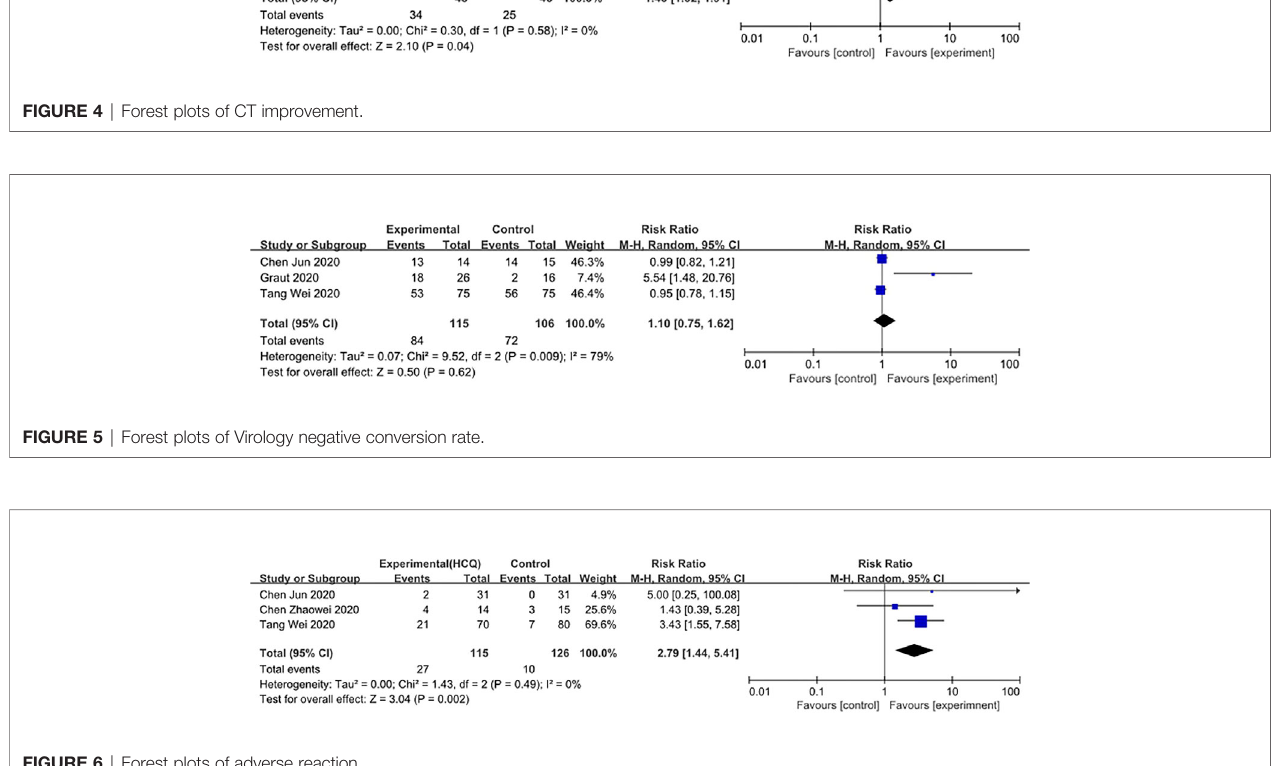
FIGURE 6 | Forest plots of adverse